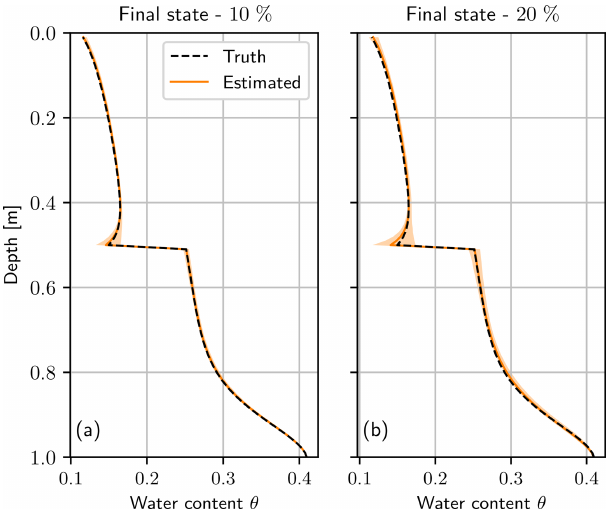
Figure 11. Final water content state after assimilation run using a bias for the upper boundary condition of (a) 10% and (b) 20%. The truth (black dashed line) is almost congruent with the estimated mean (orange line). The light orange areas represent the 95% quan- tile of the ensemble of (a) 600 and (b) 1200 ensemble